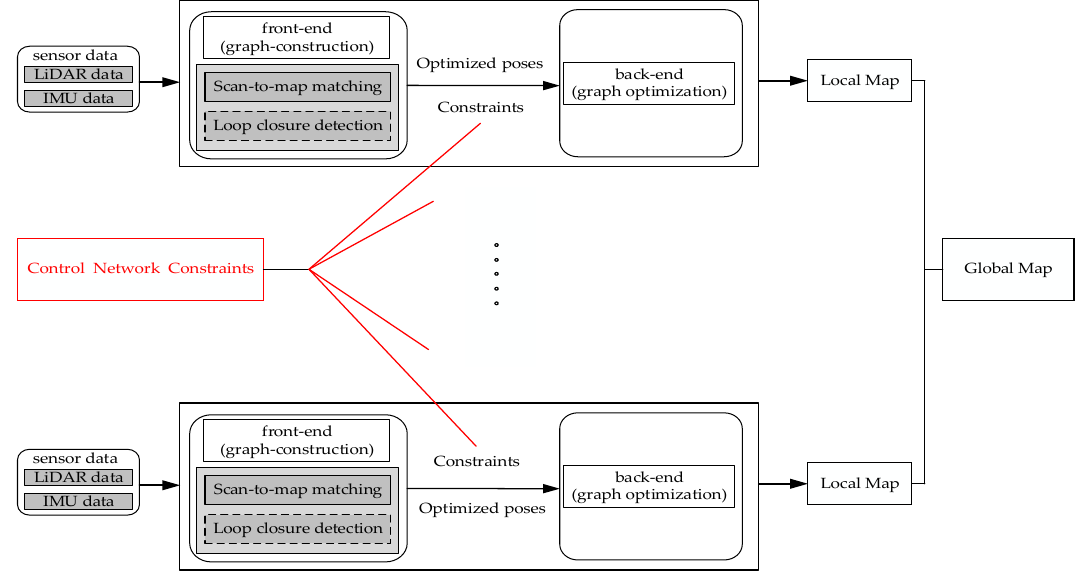
Figure 2. Distributed indoor mapping based on control-network-aided Simultaneous Localization and Mapping (SLAM) (LiDAR (Light Detection and Ranging) and IMU (International Mathematical Union)).